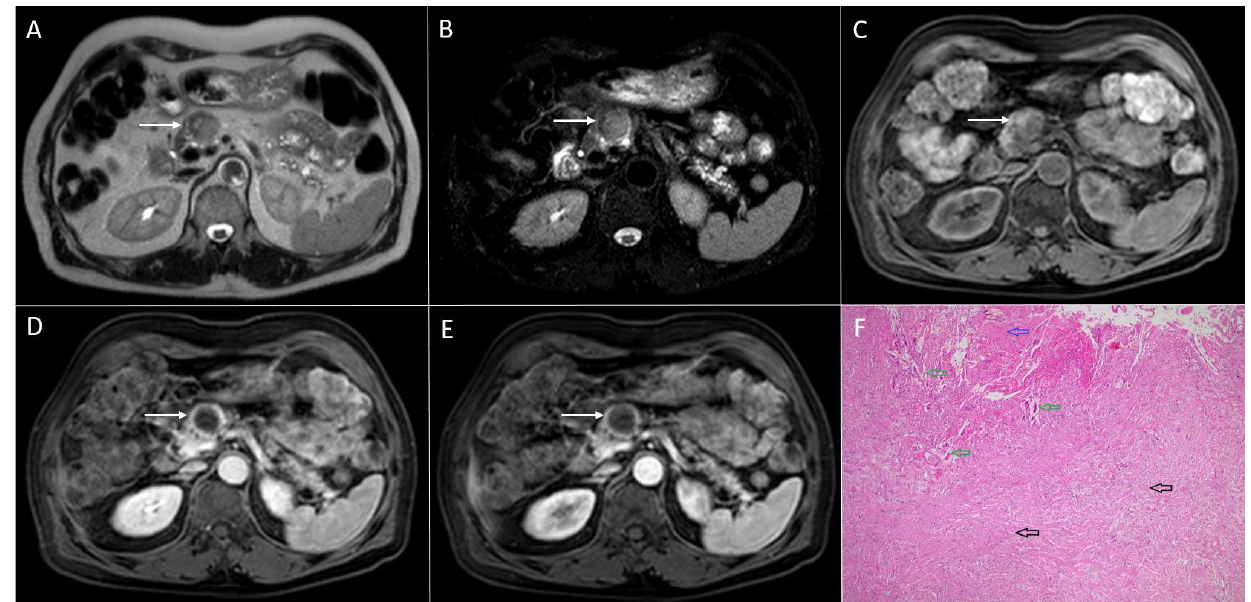
Figure 14. Walled-of necrosis in 44-year-old man. A round lesion ( arrow ) slightly hyperintense on both T2-weighted image ( A ) and T2-weighted fat-suppressed image ( B ) is seen in pancreatic head. The lesion ( arrow ) is hypointense on T1-weighted image ( C ) without enhancement in arterial phase ( D ) and portal-venous ( E ). Note only enhancing wall of the lesion. Hematoxylin and eosin (H&E) staining ( F ) showed walled-of necrosis with fibro-hyalinized wall of the cyst ( black arrows ), numerous histiocytes and foreign body giant cells ( green arrows ). Necrotic debris is also shown ( blue arrow ); original magnification ×400.